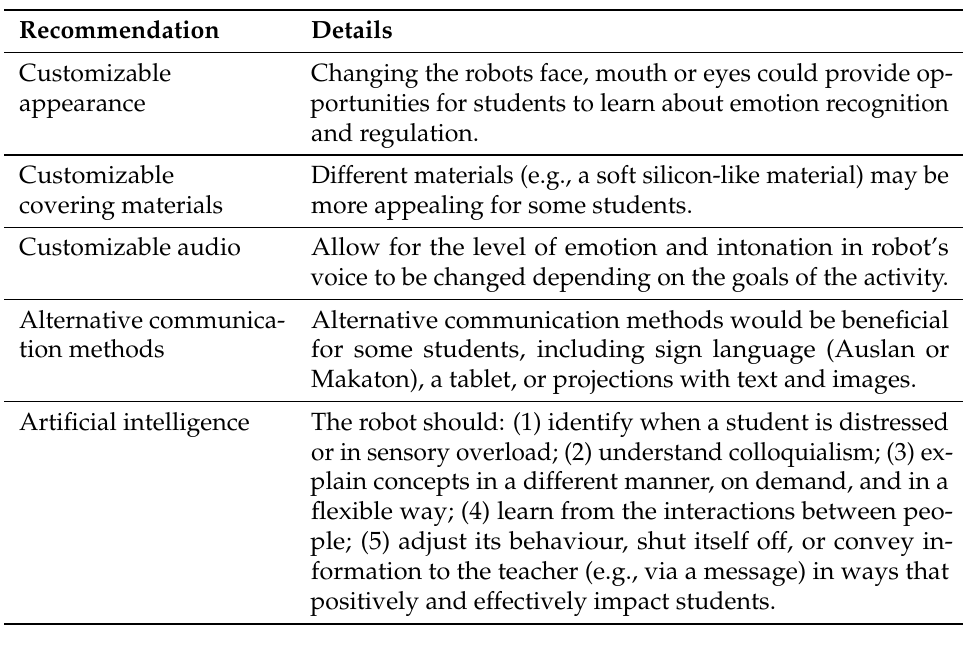
Table 6. Suggested technical